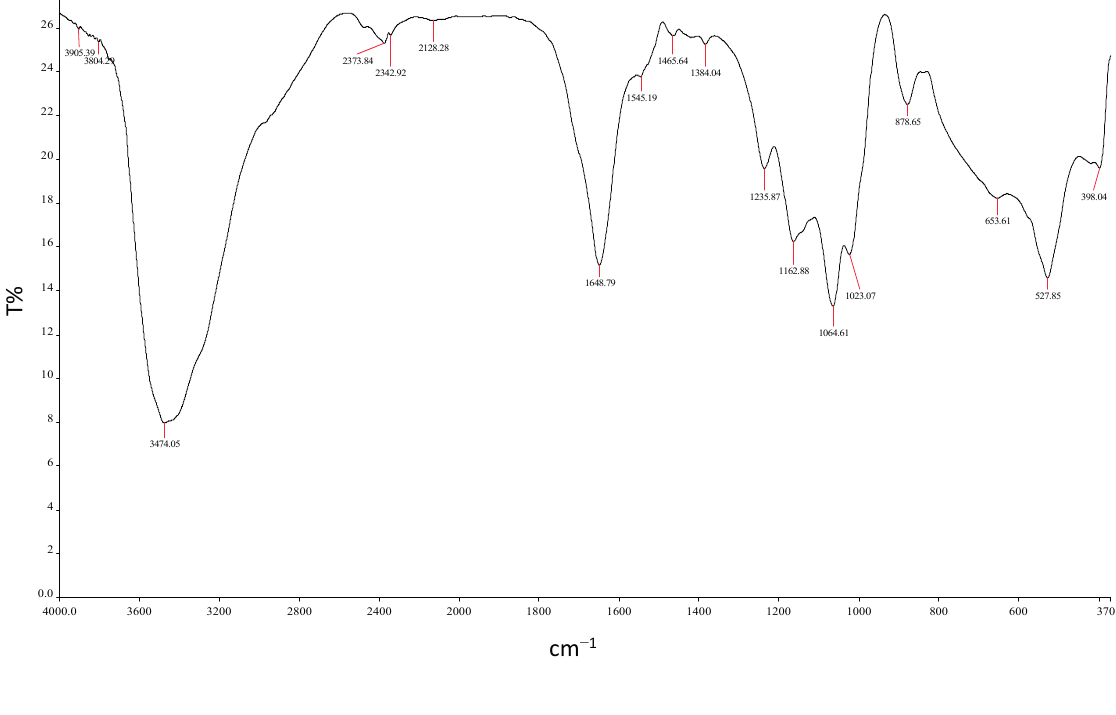
Figure 7. Functional groups identification by FTIR of REG-6 produced by Bacillus toyonensis strain AEMREG6.